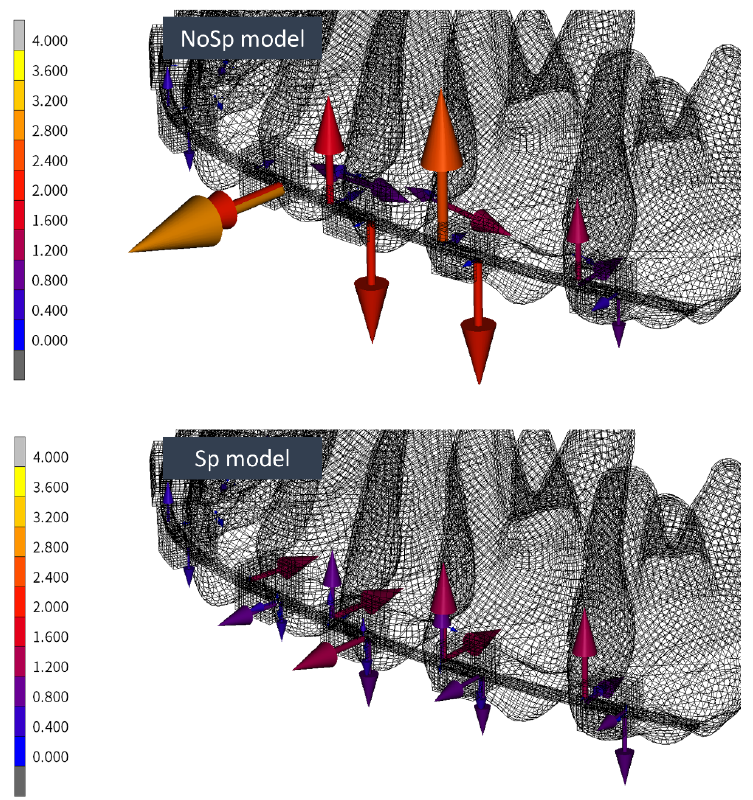
Figure 5. Contact forces between the teeth and between the brackets and the archwire. Higher levels of contact force were observed in the NoSp model.